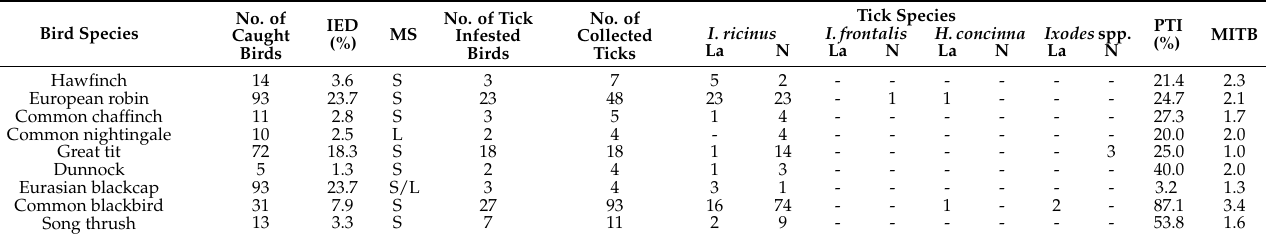
Table 1. Tick infestation among the analysed bird